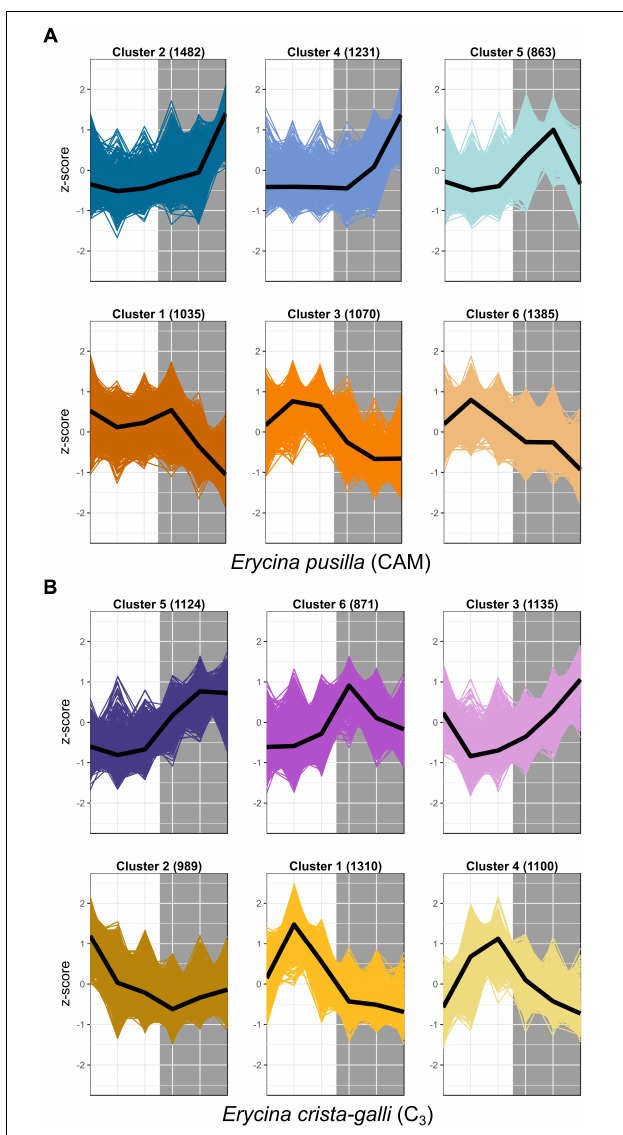
FIGURE 3 | Expression Z-scores for each gene in each cluster for both (A) E. pusilla and (B) E. crista-galli , with median expression shown in the black line. Clusters represent co-expressed genes within each species’ time-structured transcripts. Cool colors (blue and purple) are clusters with nighttime biased expression, whereas warmer colors (orange and yellow) are clusters whose transcripts increase in expression during the